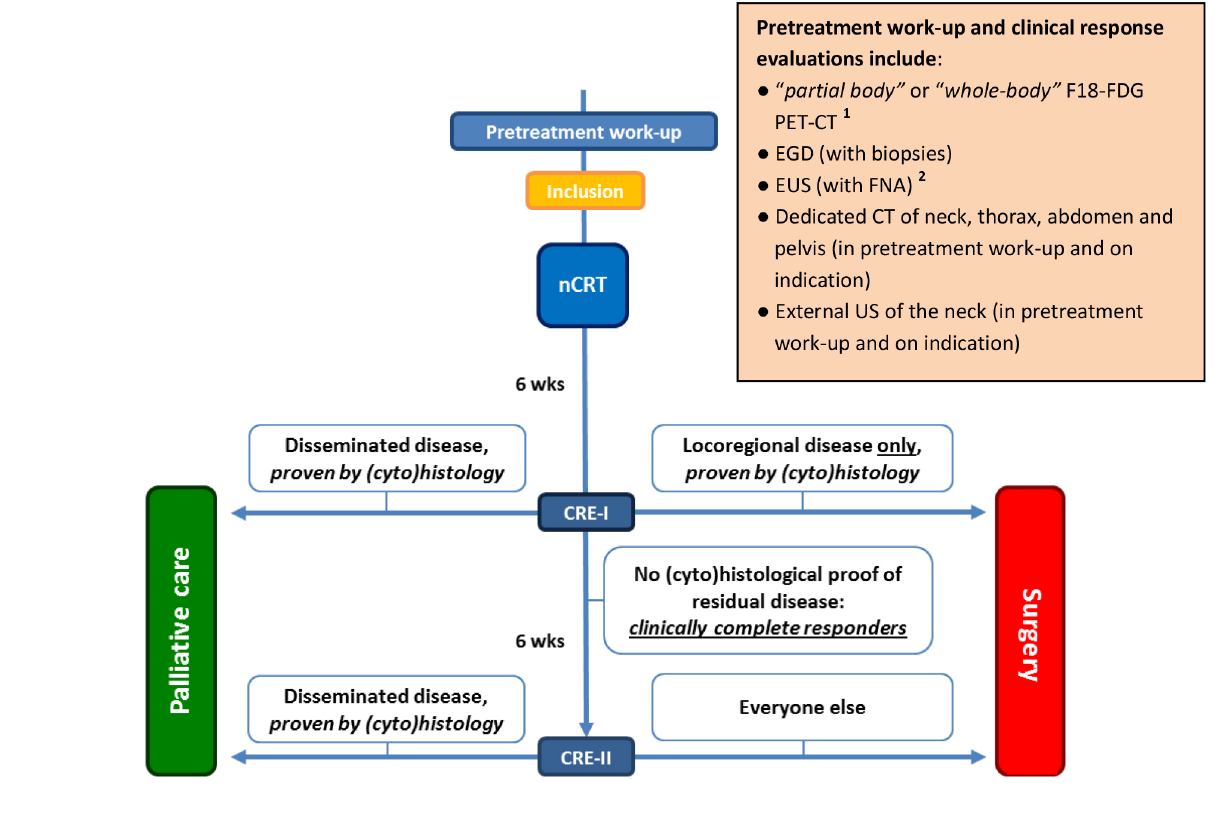
Figure 1. Study algorithm. 1. During the pretreatment workup, it suffices when a “partial body” F18-FDG PET-CT of the esophagus will be performed (to test for avidity of the primary lesion); if it is preferred to make a “whole-body” PET-CT not only after, but also before the neoadjuvant chemoradiotherapy in order to detect distant metastases at an earlier stage, the indication for performing an external US with FNA of the neck can be limited to those patients who have a suspected lymph node on the PET-CT [23]. In the period after neoadjuvant therapy, 1 whole-body F18-FDG PET-CT will be performed either at CRE-I (for the clinically noncomplete responders) or at CRE-II (for the clinically complete responders at CRE-I). 2. EUS with FNA of suspected lymph nodes only during CRE-II, not during CRE-I. CRE: clinical response evaluation; CT: computed tomography; EUS: endoscopic ultrasonography; FNA: fine-needle aspiration; nCRT: neoadjuvant chemoradiotherapy; EGD: esophagogastroduodenoscopy; PET: positron-emission tomography; US: